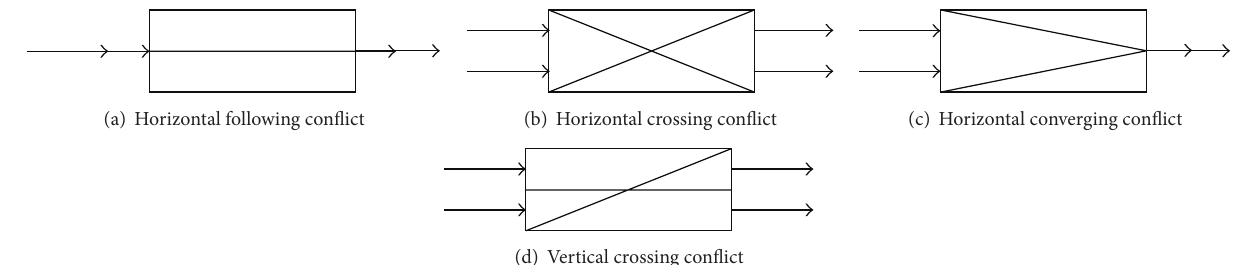
Figure 11: Graphic symbols for basic protection-zone conflict-control models.